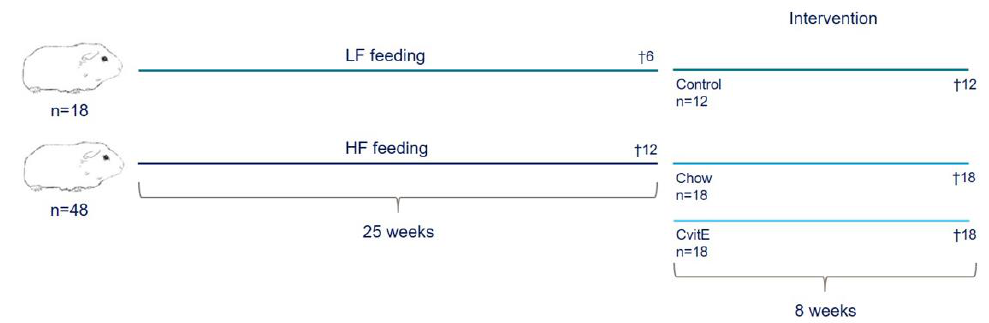
Figure 1. Study overview. Sixty-six guinea pigs were preloaded on either a standard guinea pig chow diet (4% fat, 0% cholesterol, and 0% sucrose) or high-fat diet (20% fat, 0.35% cholesterol, and 15% sucrose) for 25 weeks. Six animals receiving standard guinea pig chow diet and 12 animals receiving high-fat diet were randomly selected for euthanasia prior to intervention start, providing baseline values. The remaining animals were weight stratified into: Control ( n = 12), proceeding on the standard guinea pig chow diet (4% fat, 0% cholesterol, and 0% sucrose); Chow ( n = 18), receiving the standard guinea pig chow diet and CvitE ( n = 18), receiving the standard guinea pig chow diet supplemented with vitamin E (1125 mg / kg feed all-rac vitamin E corresponding to a daily intake of 2000 IU vitE per animal). After eight weeks of intervention, guinea pigs were euthanized. HF, high-fat diet; LF, low-fat diet. Table 1. Dietary composition.